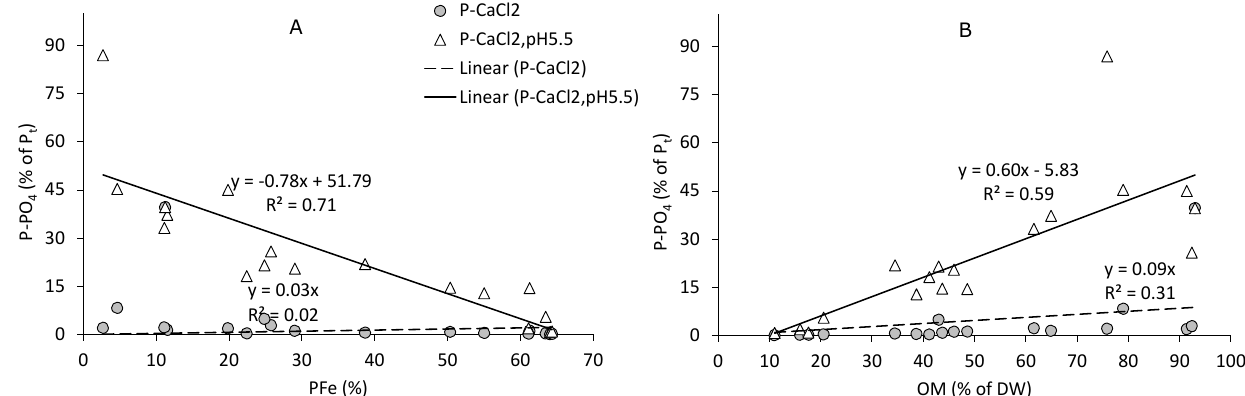
Figure 2. The relationships between P-PO 4 (% of Pt) measured in 10 mM CaCl 2 extracts (at initial pH and after acidification to pH 5.5) and ( A ) the percentage of P bound to Fe/Al-oxides (P Fe) ( B ) organic matter content (%DW) in the organic ferti- lisers.